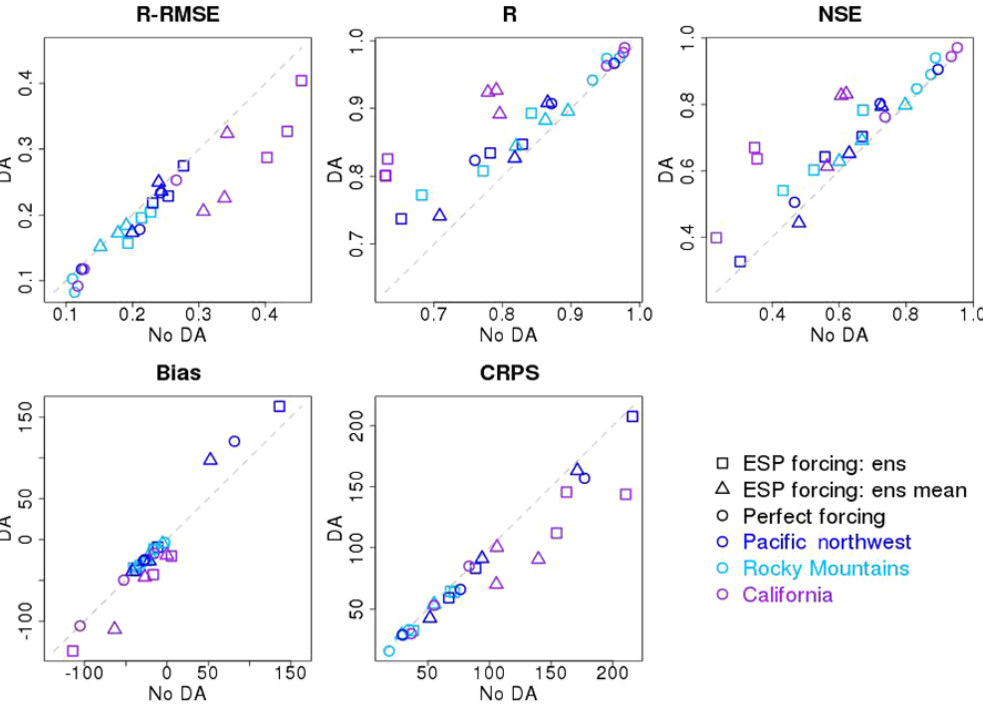
Figure 5. Evaluation statistics of percentile interpolation for the nine case basins with the two variations of ensemble streamflow prediction (ESP) and with perfect forcing data (ens in the legend denotes ensemble). The verification metrics are the same as in Fig. 4.